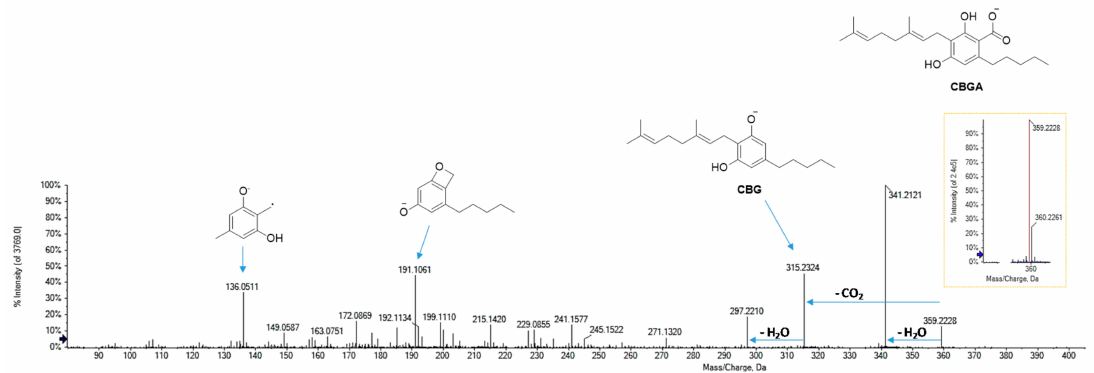
Figure 6. HR-MS and MS / MS spectra of CBGA (at m / z